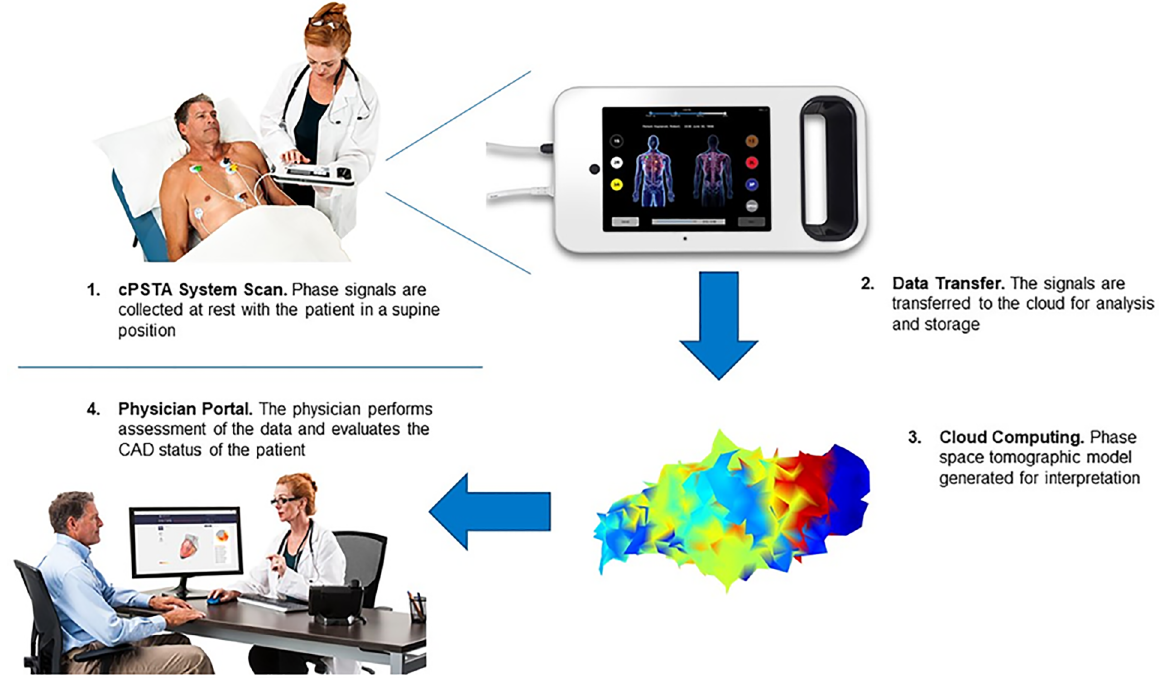
Fig 1. Utilization of the Cardiac Phase Space Tomography Analysis (cPSTA) System. Phase signal data are collected and transferred to cloud. The generated models and analysis are available for physician assessment. cPSTA System = Cardiac Phase Space Tomography Analysis System, CAD = coronary artery disease. Reprinted from presentation materials of A4L under a license, with permission from A4L and W20, original production 2016.